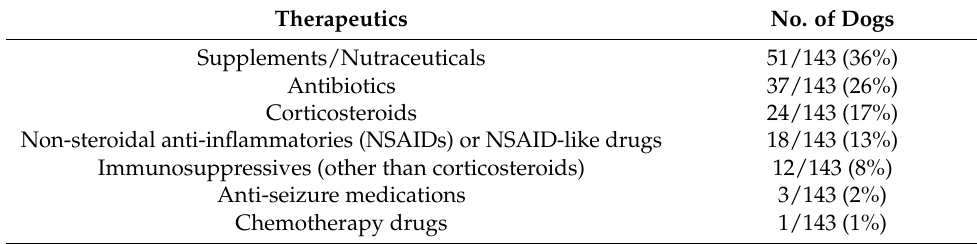
Table 5. Pre-existing medical therapies and nutraceuticals reported in survey data from dogs with a serum cPLI concentration ≥ 400 µ